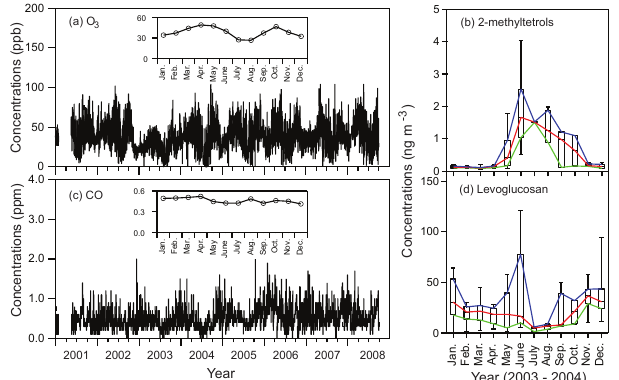
Figure 4. Seasonal variations in chemical tracers in the atmosphere at Gosan: (a) ozone (O 3 ) , (b) 2-methyltetrols, (c) carbon monoxide (CO) and (d) levoglucosan. O 3 and CO data were obtained from the Korea Meteorological Administration (KMA). The insets in the left panels show the monthly averaged concentrations of O 3 and CO during the time period of 2001–2008.